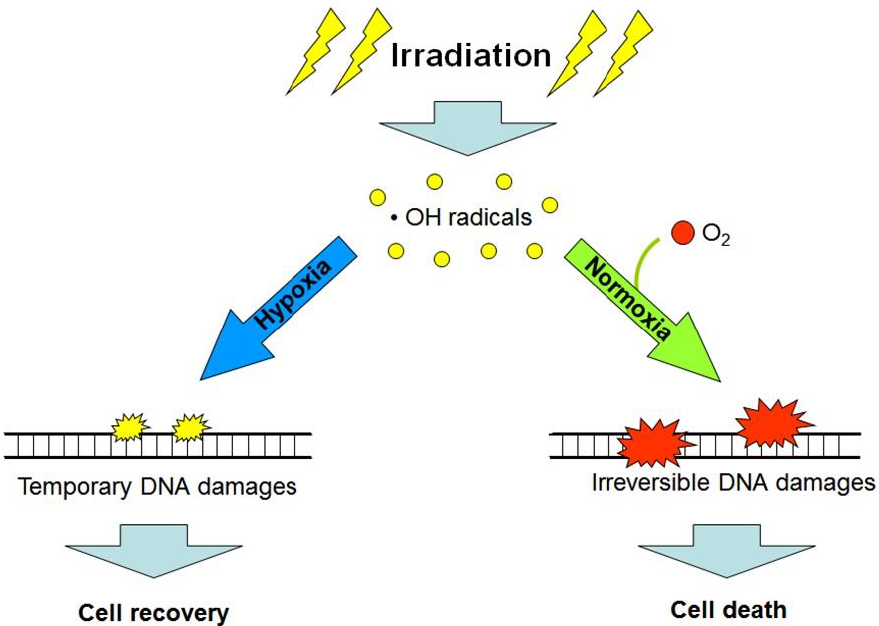
Figure 3. Simplified scheme explaining the “oxygen effect”: low linear energy transfer (LET) radiation exposure in the presence of oxygen (O 2 ) produces greater amounts of non-reparable and lethal DNA damages in target cells, as compared with analogous exposure under hypoxic or anoxic conditions (see the text and references [4,10]).